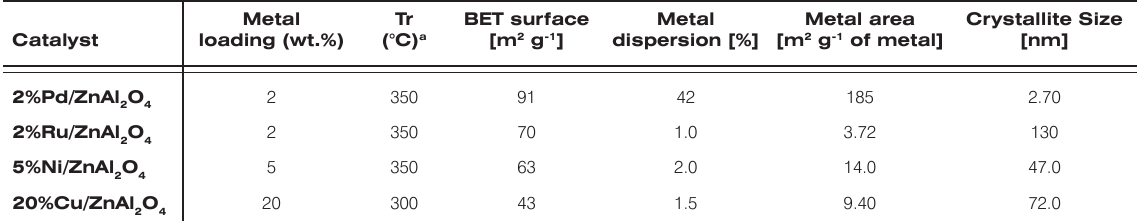
Table 1. BET surface area measurements of transition metal catalysts calcined in air at 400°C various temperatures and dispersion degree of the metallic phase. Metal Catalyst loading (wt.%)